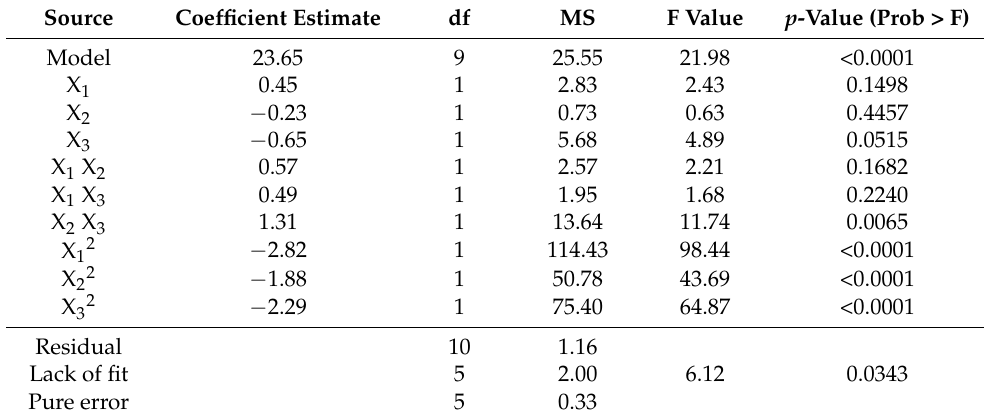
Table 5. ANOVA for response surface quadratic model of lactic acid production.